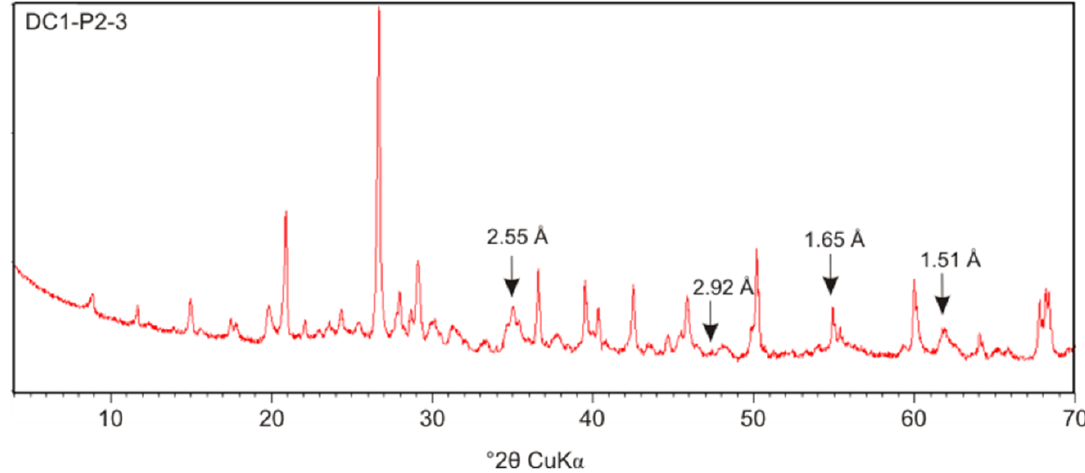
Figure 6. X-ray power diffraction pattern for the bulk sample DC1-P2-3. The arrows indicate the positions (d(Å)) of the main peaks for schwertmannite. The shape and intensities of the two main peaks (2.55 and 1.51 Å) suggest the presence of schwertmannite in this